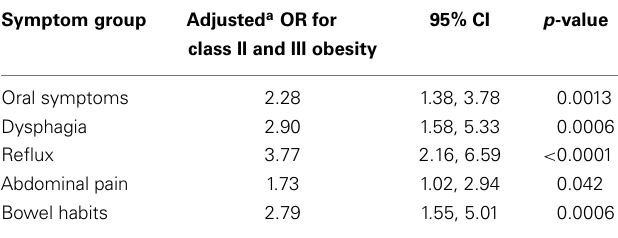
Table 3 | Multivariate regression results for presence of any symptom within the symptom group